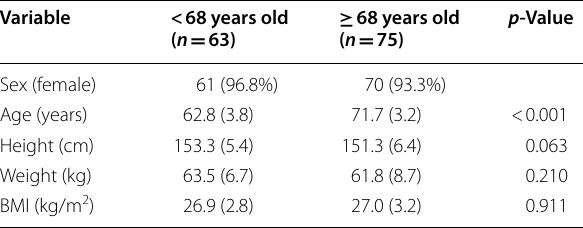
Table 1 Demographic data of patients in the two age groups